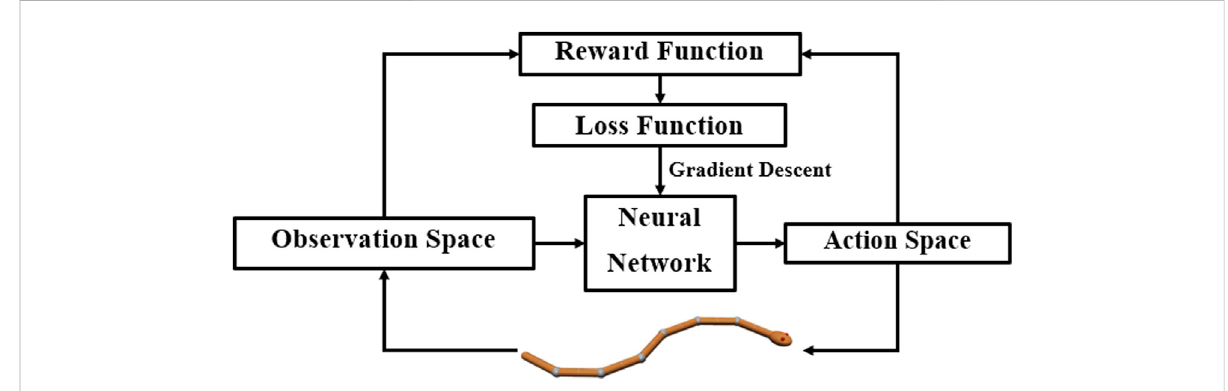
FIGURE 2 Perception – action – learningloopoftheDRLcontroller.Attime t ,theagentreceivesthestate s t fromtheenvironment.Theagentusesitspolicy to choose an action a t . Once the action is executed, the environment transitions a step, providing the next state, s t +1 , as well as feedback in the form of a reward, r t +1 . The agent uses knowledge of state transitions, of the form ( s t , a t , s t +1 , r t +1 ), to learn and improve its